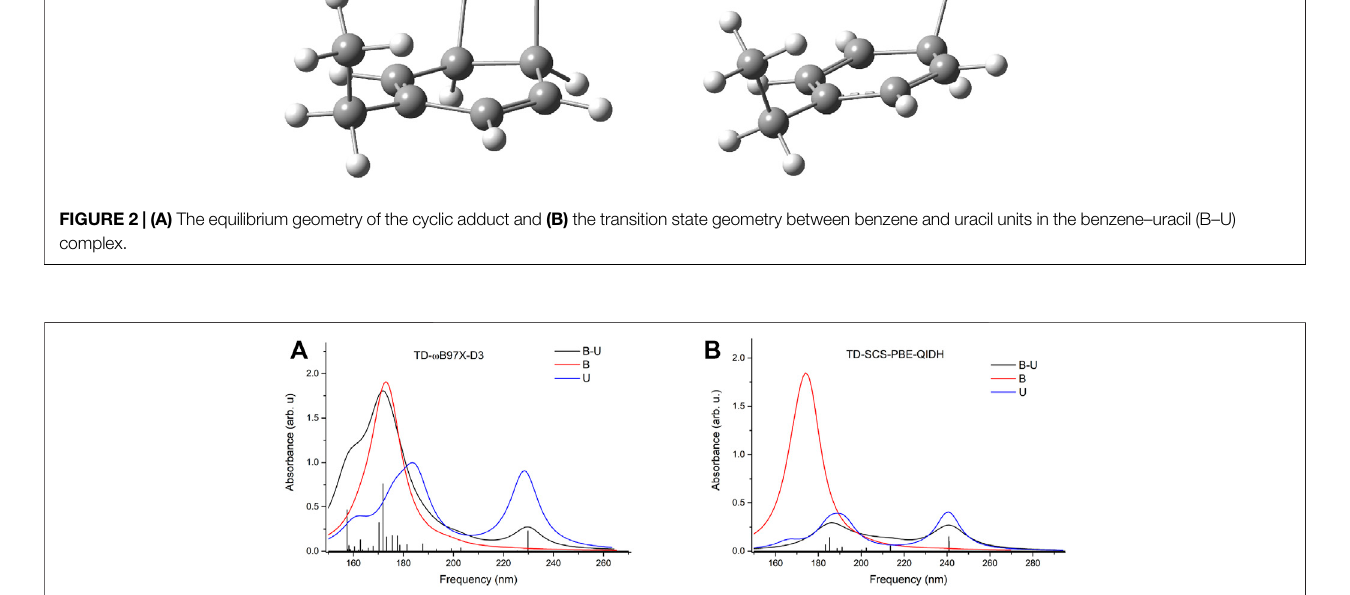
FIGURE 3 | The theoretical UV spectra (black) obtained considering the ω B97X-D3 (A) and SCS-PBE-QIDH (B) XC functionals. The UV spectra of the individual benzene (red) and uracil (blue) are also included.